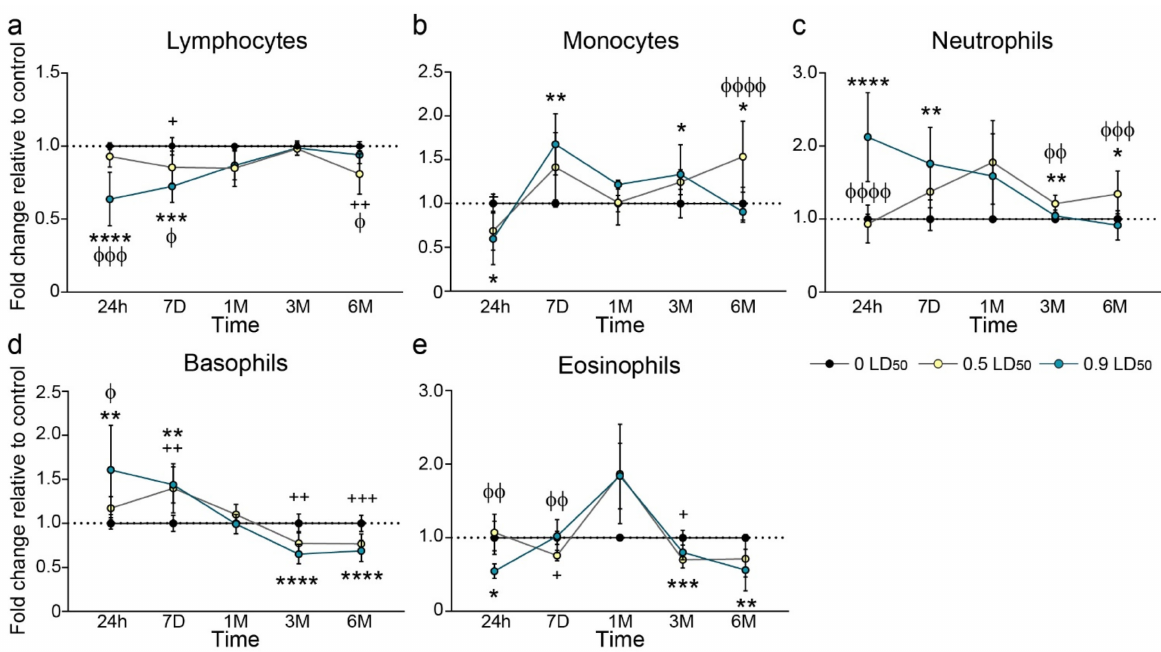
Figure 5. Evolution in white blood cell count after NIMP exposure. ( a ) Lymphocyte count at different timepoints after NIMP exposure relative to CTL: 24 h (1.0 ± 0.01 for 0 LD50; 0.93 ± 0.02 for 0.5 LD50 and 0.64 ± 0.06 for 0.9 LD50); 7 days (1.0 ± 0.02 for 0 LD50; 0.85 ± 0.03 for 0.5 LD50 and 0.72 ± 0.04 for 0.9 LD50); 1 month (1.0 ± 0.004 for 0 LD50; 0.85 ± 0.07 for 0.5 LD50 and 0.87 ± 0.05 for 0.9 LD50); 3 months (1.0 ± 0.003 for 0 LD50; 0.98 ± 0.01 for 0.5 LD50 and 0.99 ± 0.02 for 0.9 LD50) and 6 months (1.0 ± 0.12 for 0 LD50; 0.81 ± 0.05 for 0.5 LD50 and 0.94 ± 0.02 for 0.9 LD50); ( n = 8 to 10 per group). Significant differences were determined by one-way ANOVA (F = 22.52, p < 0.0001 for 24H; F = 13.33, p = 0.0002 for 7D; F = 5.21, p = 0.02 for 1M; F = 0.32, p = 0.73 for 3M and F = 8.51, p = 0.0023 for 6M with Tukey’s multiple comparisons test. ( b ) Monocyte count at different timepoints after NIMP exposure relative to CTL: 24 h (1.0 ± 0.04 for 0 LD50; 0.69 ± 0.08 for 0.5 LD50 and 0.60 ± 0.13 for 0.9 LD50); 7 days (1.0 ± 0.02 for 0 LD50; 1.41 ± 0.12 for 0.5 LD50 and 1.68 ± 0.12 for 0.9 LD50); 1 month (1.0 ± 0.04 for 0 LD50; 1.01 ± 0.12 for 0.5 LD50 and 1.22 ± 0.02 for 0.9 LD50); 3 months (1.0 ± 0.06 for 0 LD50; 1.24 ± 0.05 for 0.5 LD50 and 1.33 ± 0.11 for 0.9 LD50) and 6 months (1.0 ± 0.07 for 0 LD50; 1.53 ± 0.13 for 0.5 LD50 and 0.90 ± 0.03 for 0.9 LD50); ( n = 8 to 10 per group). Significant differences were determined by one-way ANOVA (F = 5.54, p = 0.015 for 24H; F = 6.39, p = 0.0065 for 7D; F = 2.88, p = 0.095 for 1M; F = 4.46, p = 0.024 for 3M and F = 15.78, p < 0.0001 for 6M with Tukey’s multiple comparisons test. ( c ) Neutrophil count at different timepoints after NIMP exposure relative to CTL: 24 h (1.0 ± 0.02 for 0 LD50; 0.93 ± 0.08 for 0.5 LD50 and 2.12 ± 0.23 for 0.9 LD50); 7 days (1.0 ± 0.06 for 0 LD50; 1.37 ± 0.11 for 0.5 LD50 and 1.76 ± 0.15 for 0.9 LD50); 1 month (1.0 ± 0.02 for 0 LD50; 1.77 ± 0.33 for 0.5 LD50 and 1.59 ± 0.29 for 0.9 LD50); 3 months (1.0 ± 0.01 for 0 LD50; 1.21 ± 0.04 for 0.5 LD50 and 1.04 ± 0.03 for 0.9 LD50) and 6 months (1.0 ± 0.03 for 0 LD50; 1.34 ± 0.11 for 0.5 LD50 and 0.92 ± 0.06 for 0.9 LD50); ( n = 8 to 10 per group). Significant differences were determined by one-way ANOVA (F = 27.24, p < 0.0001 for 24H; F = 7.68, p = 0.0028 for 7D; F = 3.7, p = 0.067 for 1M; F = 12.19, p = 0.0003 for 3M and F = 9.50, p = 0.0009 for 6M with Tukey’s multiple comparisons test. ( d ) Basophil count at different timepoints after NIMP exposure relative to CTL: 24 h (1.0 ± 0.03 for 0 LD50; 1.17 ± 0.04 for 0.5 LD50 and 1.60 ± 0.17 for 0.9 LD50); 7 days (1.0 ± 0.03 for 0 LD50; 1.40 ± 0.09 for 0.5 LD50 and 1.44 ± 0.08 for 0.9 LD50); 1 month (1.0 ± 0.01 for 0 LD50; 1.10 ± 0.06 for 0.5 LD50 and 0.99 ± 0.04 for 0.9 LD50); 3 months (1.0 ± 0.05 for 0 LD50; 0.77 ± 0.04 for 0.5 LD50 and 0.65 ± 0.03 for 0.9 LD50) and 6 months (1.0 ± 0.03 for 0 LD50; 0.77 ± 0.03 for 0.5 LD50 and 0.69 ± 0.03 for 0.9 LD50); ( n = 8 to 10 per group). Significant differences were determined by one-way ANOVA (F = 7.218, p = 0.0041 for 24H; F = 9.08, p = 0.0016 for 7D; F = 1.84, p = 0.19 for